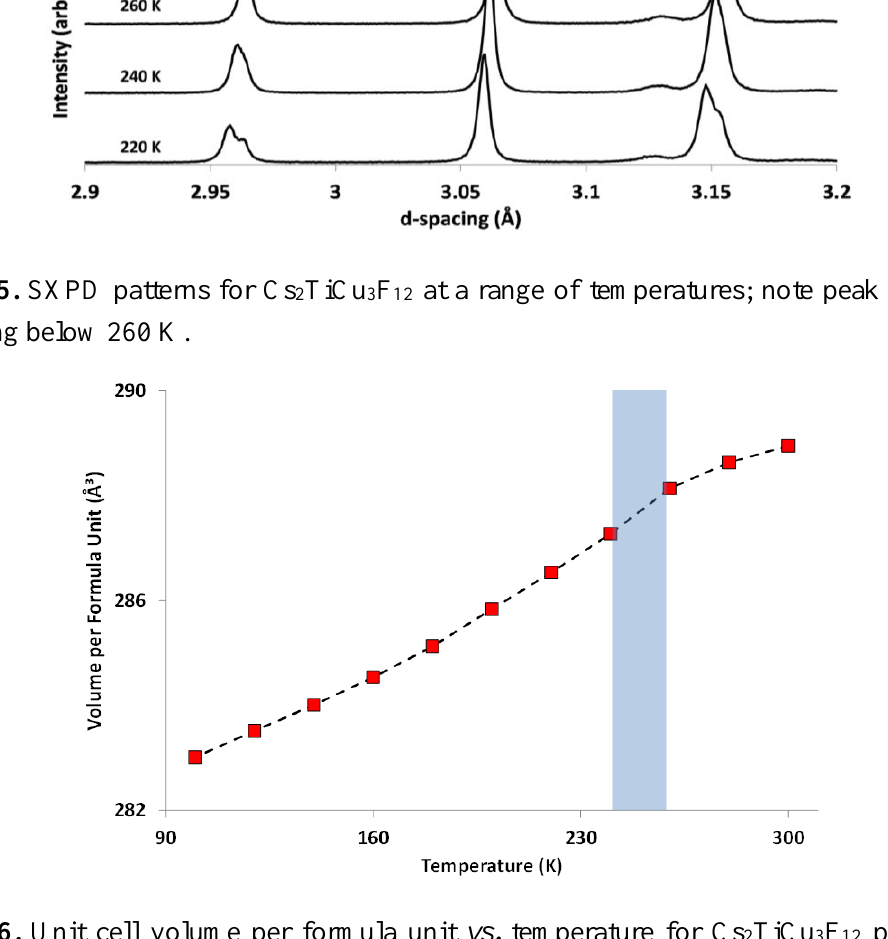
Figure 6. Unit cell volume per formula unit vs. temperature for Cs 2 TiCu 3 F 12 powder as derived from SXPD data. Note the change in gradient indicated by the shaded